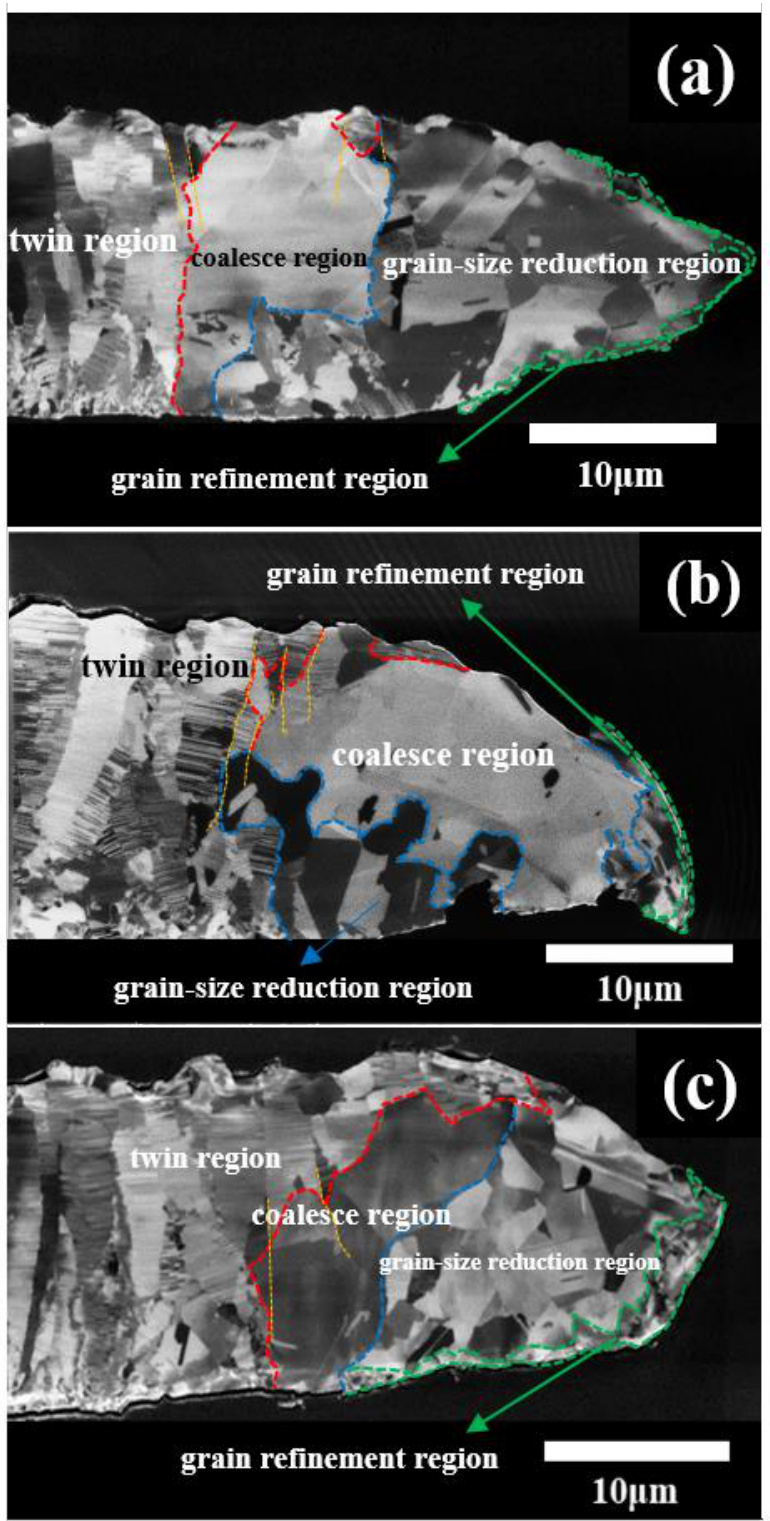
Figure 3. FIB images show the fractured nt-Cu films ( a – c ) after the tensile tests plated with the concentration of gelatin (8 g/L), (7.9 g/L), and (7.8 g/L), respectively. We clearly observed the necking phenomenon and defined the coalesce region, grain-size reduction region and grain refinement region in the necking area from images ( a – c ), respectively.